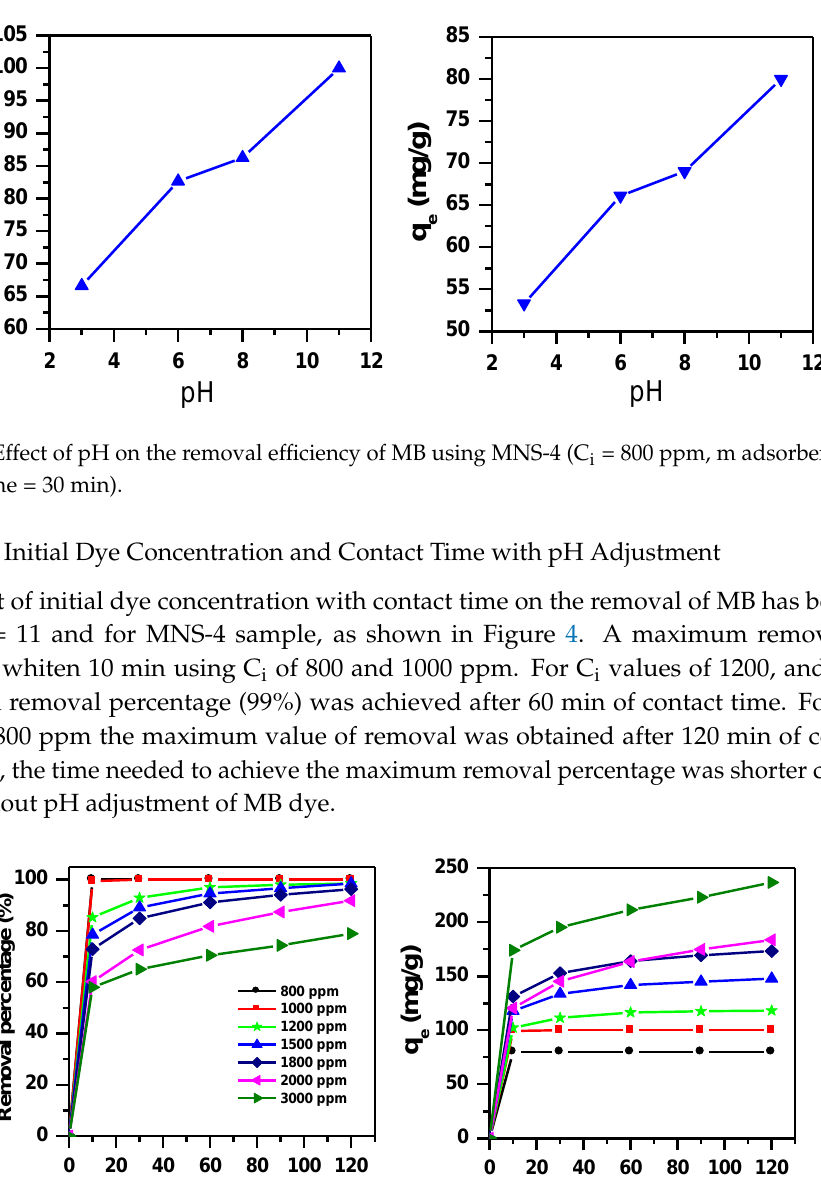
Figure 4. Effect of initial dye concentration on removal efficiency of MB using MNS-4 (m adsorbent = 1 g, pH = 11).